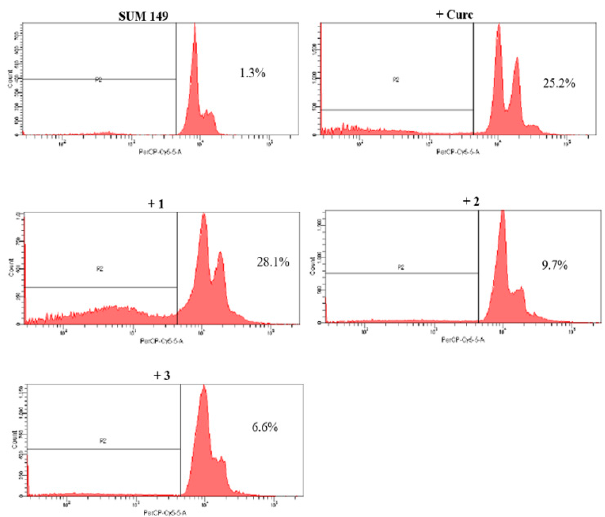
Figure 4. Representative example of flow cytometry analysis with propidium iodide. SUM 149 cells were treated with curcumin and its analogues at 15 μ M for 24 h. Numbers in the panels indicate the % of the events in the preG 0 –G 1 position.